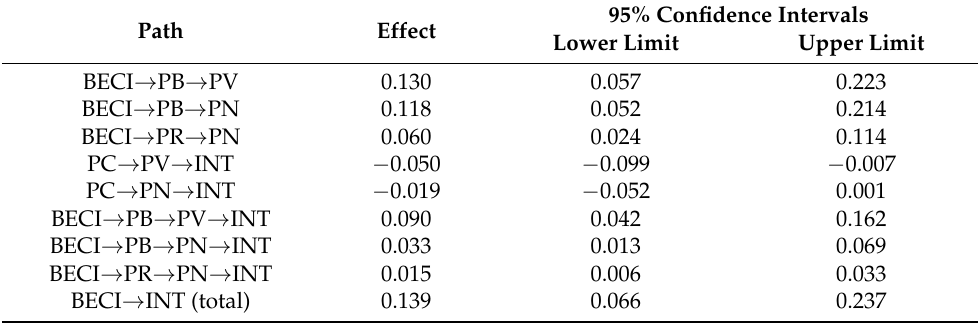
Table 5. Results of mediation effect